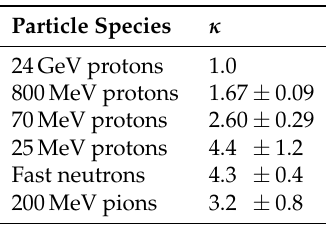
Figure 7. The 1/ λ for scCVD and pCVD diamond in the pion irradiation. The two values shown at each fluence are the values for positive (solid markers) and negative (open markers) bias at E = The data were fit with a simple damage curve independently for each diamond type. The uncertainty for unirradiated scCVD diamond comes from not knowing the upper initial mean drift distance exactly. Table 4. Relative damage constants for 24GeV protons, 800MeV protons, 70MeV protons, 25MeV protons, fast reactor neutrons, and 200MeV pions. The radiation damage constants of 24GeV protons and 800MeV protons are from [4]. The relative radiation damage constant of 25MeV protons is derived from